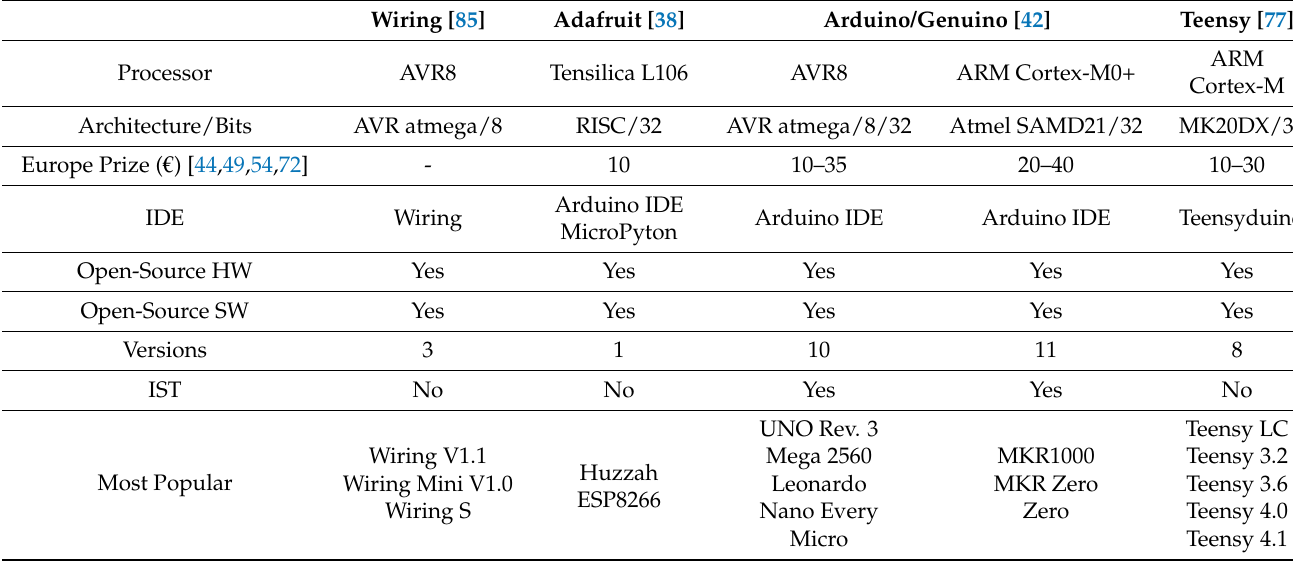
Table 2. Main open-source SBMs in the